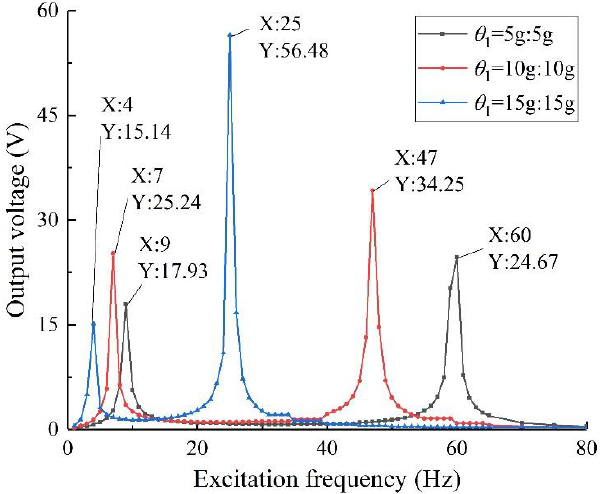
Figure 10. Output performance of different mass ratios ( h 1 = 0.30 mm).